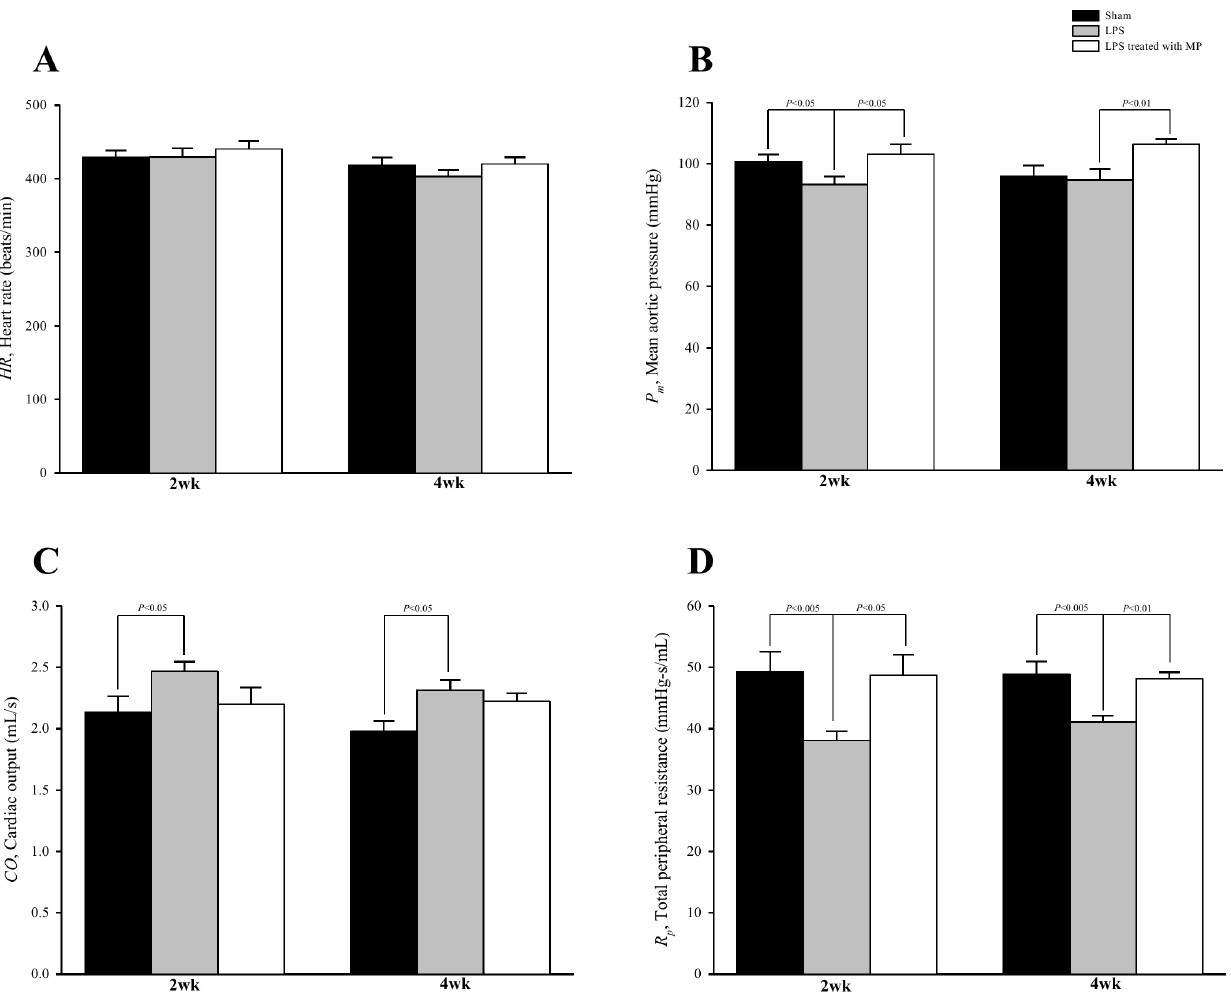
Figure 5. Effects of LPS and MP on basal heart rate ( HR in A), mean aortic pressure ( P m in B), cardiac output ( CO in C) and total peripheral resistance ( R p in D). Data are expressed as mean 6 s.e. LPS, lipopolysaccharide; MP, methylprednisolone. ( n =10 in each